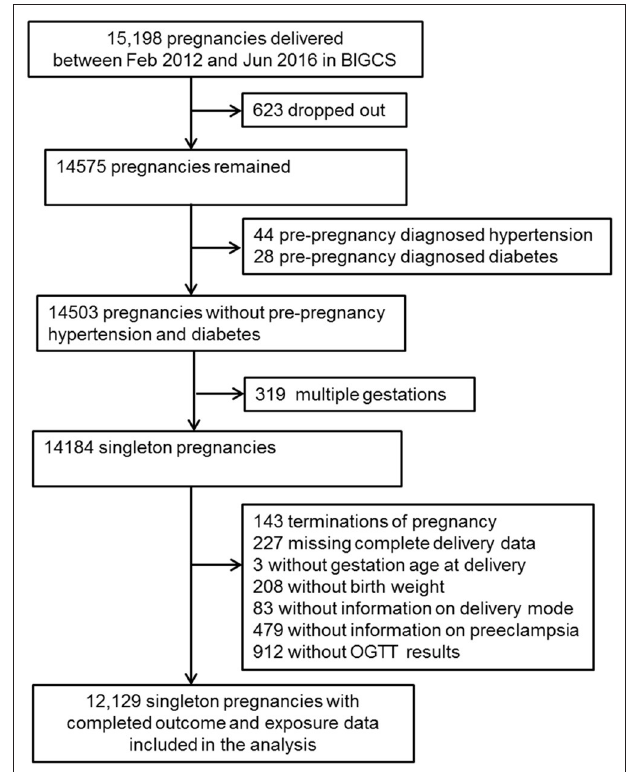
FIGURE 1 | The flowchart of the